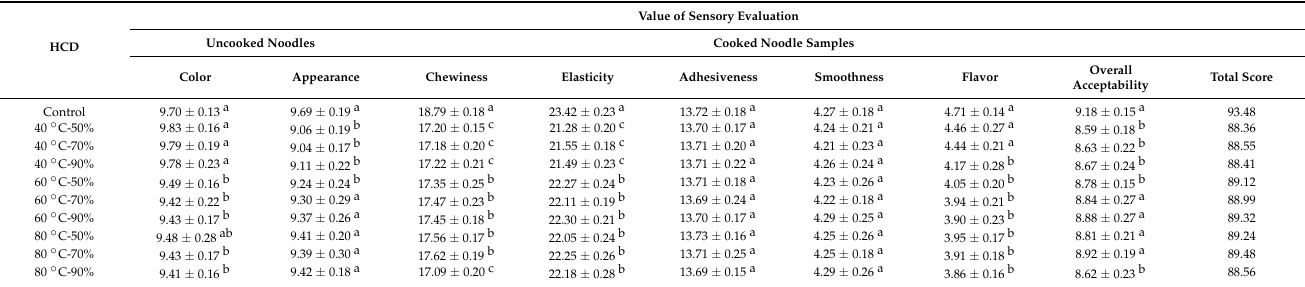
Table 2. Effect of humidity-controlled dehydration (HCD) on the sensory evaluation of uncooked and cooked fresh wheat noodles